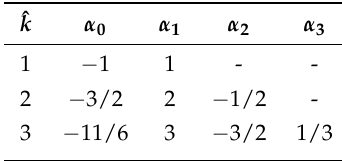
Table 1. Coefficients of BDF integration